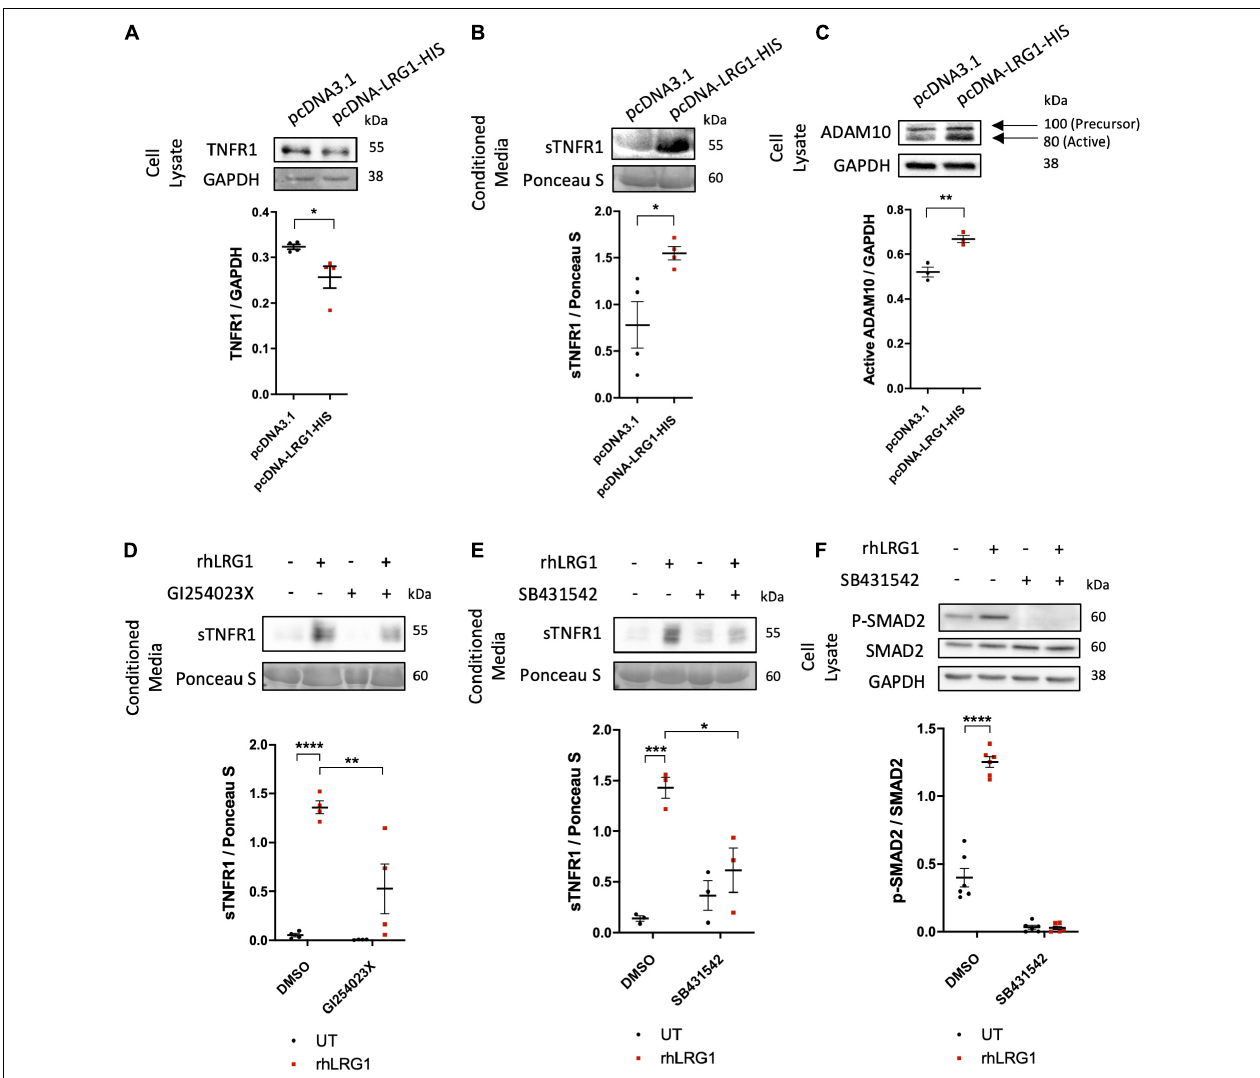
FIGURE 5 | Recombinant human LRG1 (rhLRG1) induced TNFR1 shedding via ADAM10 and ALK5. Effect of LRG1 overexpression on levels of (A) TNFR1 and (C) ADAM10 in HUVECs, and (B) soluble TNFR1 (sTNFR1) in HUVEC-conditioned medium. (D) Levels of sTNFR1 in medium conditioned by HAECs that had been treated with rhLRG1 (with PBS as a control) and/or an ADAM10 inhibitor. rhLRG1 significantly increased the expression of sTNFR1 in conditioned medium and its activity was significantly reduced in the presence of an ADAM10 inhibitor. (E) sTNFR1 in the conditioned medium of HAECs and (F) SMAD2 in HAECs treated with rhLRG1 (with PBS as control) and/or an ALK5 inhibitor. rhLRG1 significantly increased the expression of sTNFR1 in conditioned medium and its activity was significantly reduced in the presence of the ALK5 inhibitor. rhLRG1 also increased SMAD2 activation, and the diminished pSMAD2 expression in HAECs